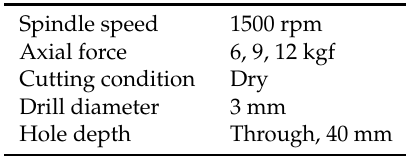
Table 1. The parameters for experimental